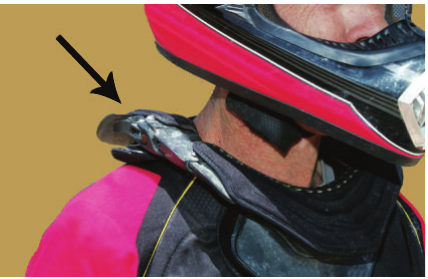
Figure2:Amotocrossrider(notourpatient)shownwearingaLeatt neck brace